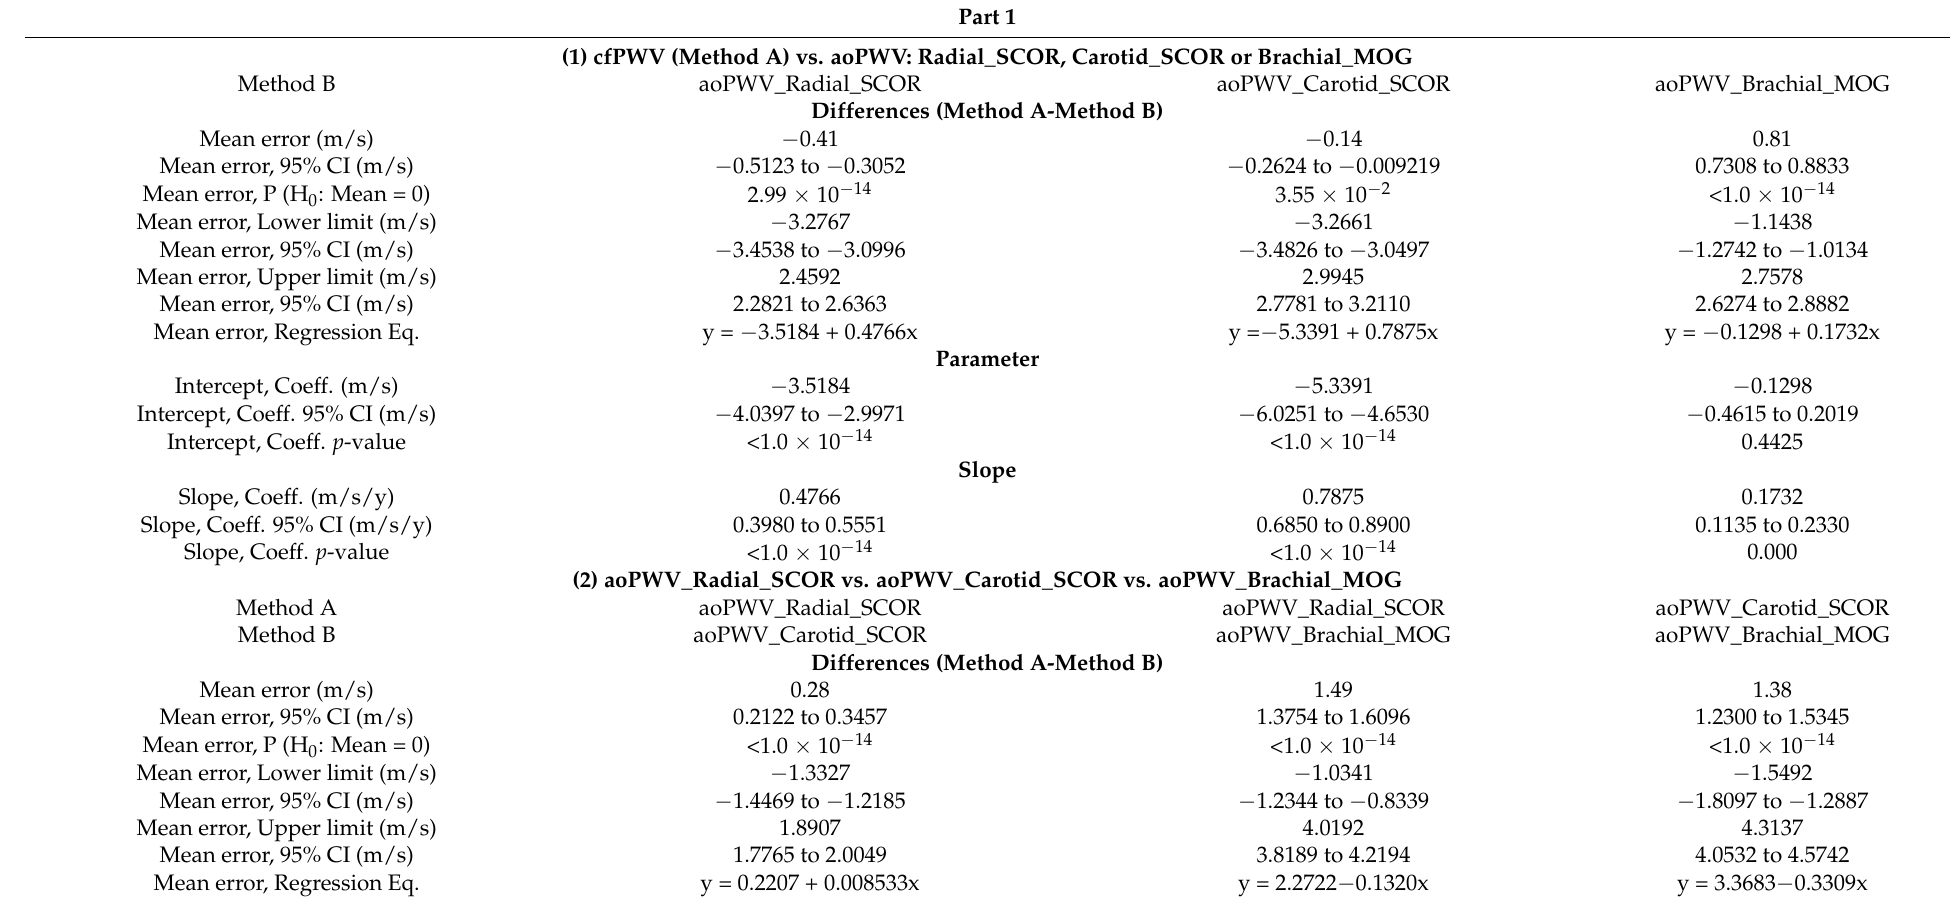
Table 5. Bland–Altman test between arterial stiffness parameters (Reference Interval